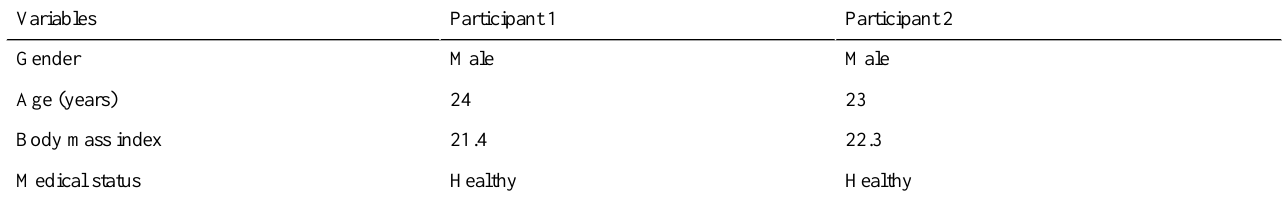
Table 2. Participant characteristics (N=2).